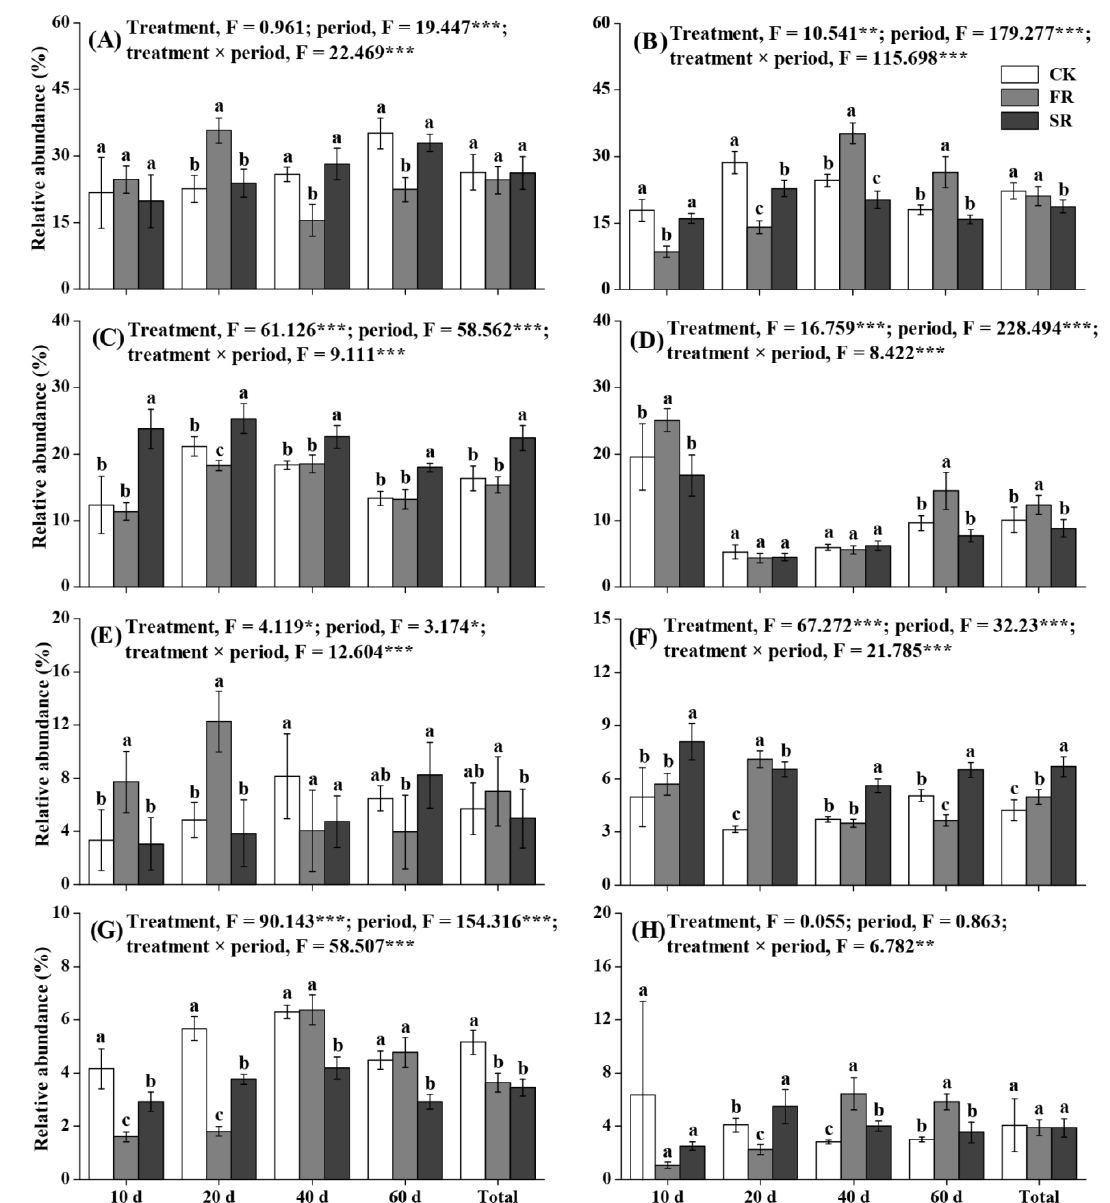
Figure 6. Relative abundances (>3%) of the selected bacterial phyla response to straw application: ( A ) Planctomycetes , ( B ) Proteobacteria , ( C ) Acidobacteria , ( D ) Actinobacteria , ( E ) Verrucomicrobia , ( F ) Chloroflexi , ( G ) Gemmatimonadetes and ( H ) Bac- teroidetes . CK, no straw application; FR, one-year straw application; SR, two-year straw application. Labels of the abscissa axis indicate the survey time (day after sowing), and total indicates the mean value for each period. Error bars indicate the standard error, and different letters indicate significant differences at the 0.05 level (Tukey’s HSD test). The text in the figure represents the effects of the treatment and period based on the repeated-measures ANOVA. * p < 0.05, ** p < 0.01 and *** p <